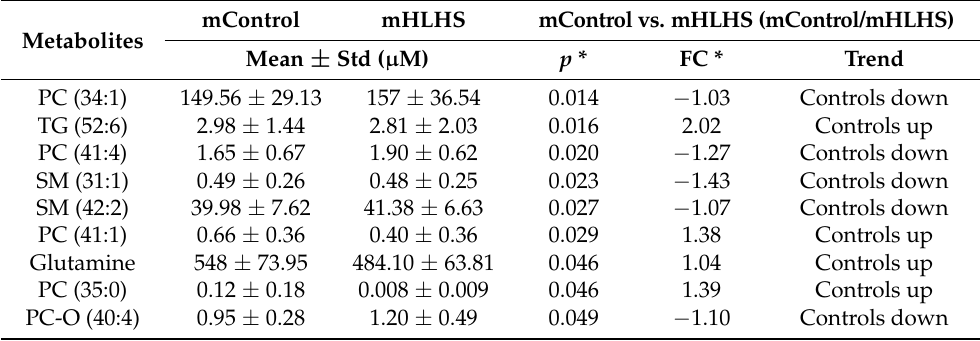
Table 2. Significant metabolites between the mothers of control infants (mControl) compared to the mothers of infants with hypoplastic left heart syndrome (mHLHS), Arkansas site of NBDPS, 1997–2011. Metabolites